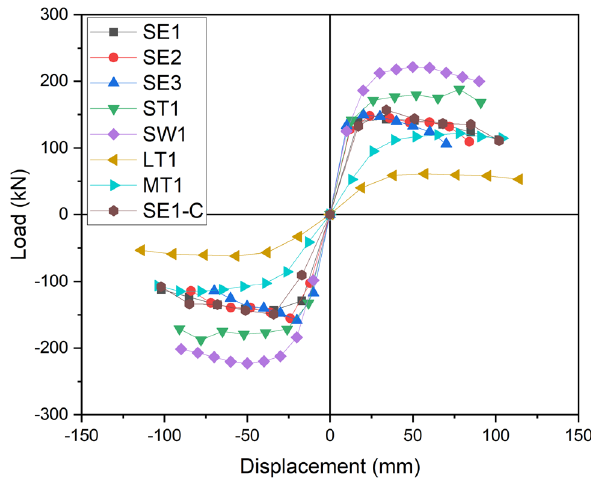
Figure 11: Skeleton curve of typical specimens.